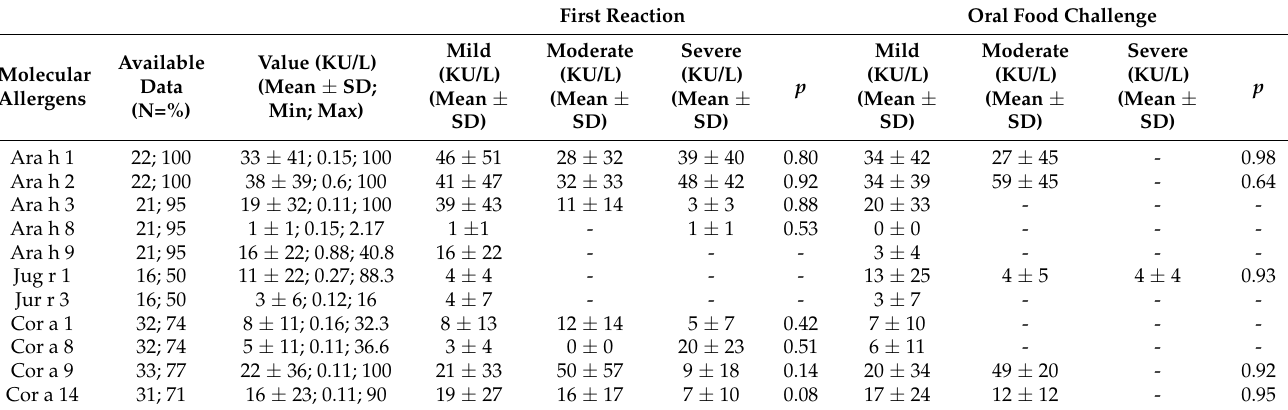
Table 5. Molecular allergens, severity of the first nut reaction, and severity of the positive oral food challenge. First Reaction Oral Food Challenge Molecular